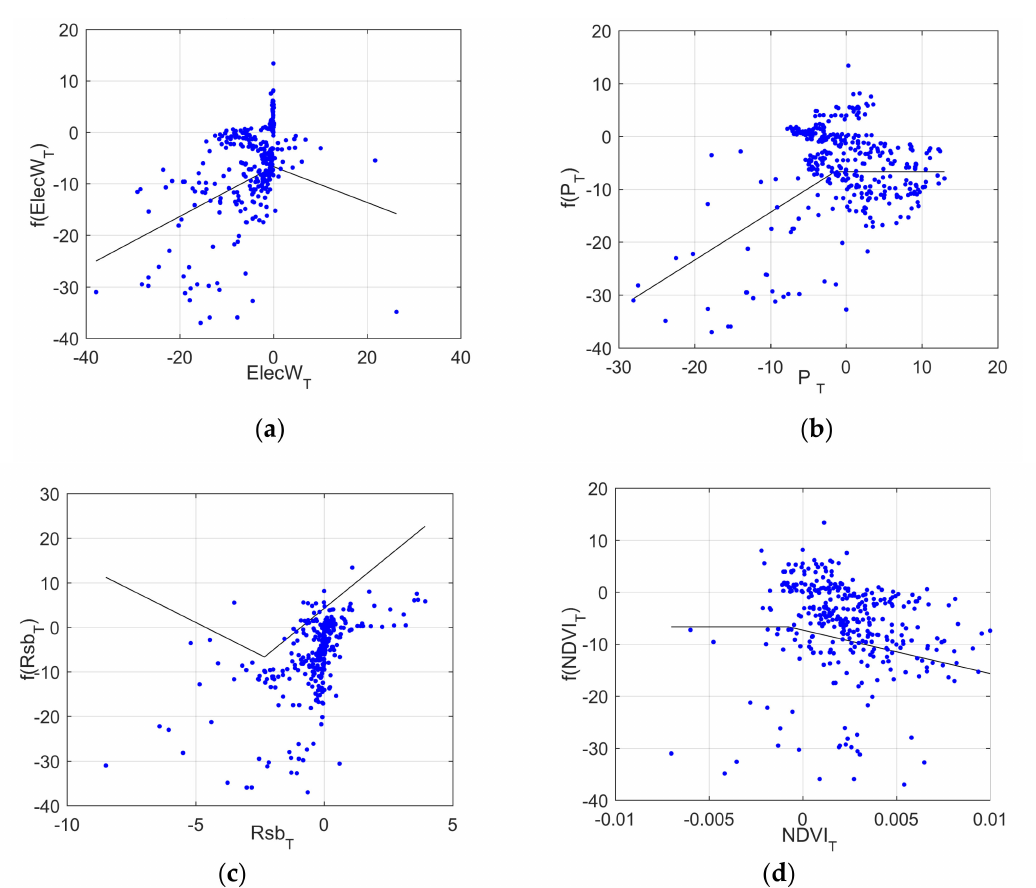
Figure 7. Influence of single variable ( a ) ElecW, ( b ) P, ( c ) Rsb, and ( d ) NDVI. identified by MARS model on the TWS trend. Scatter plot is the relationship for the single variable trend and TWS trend calculated by GRACE. The T subscript refers to the slope of